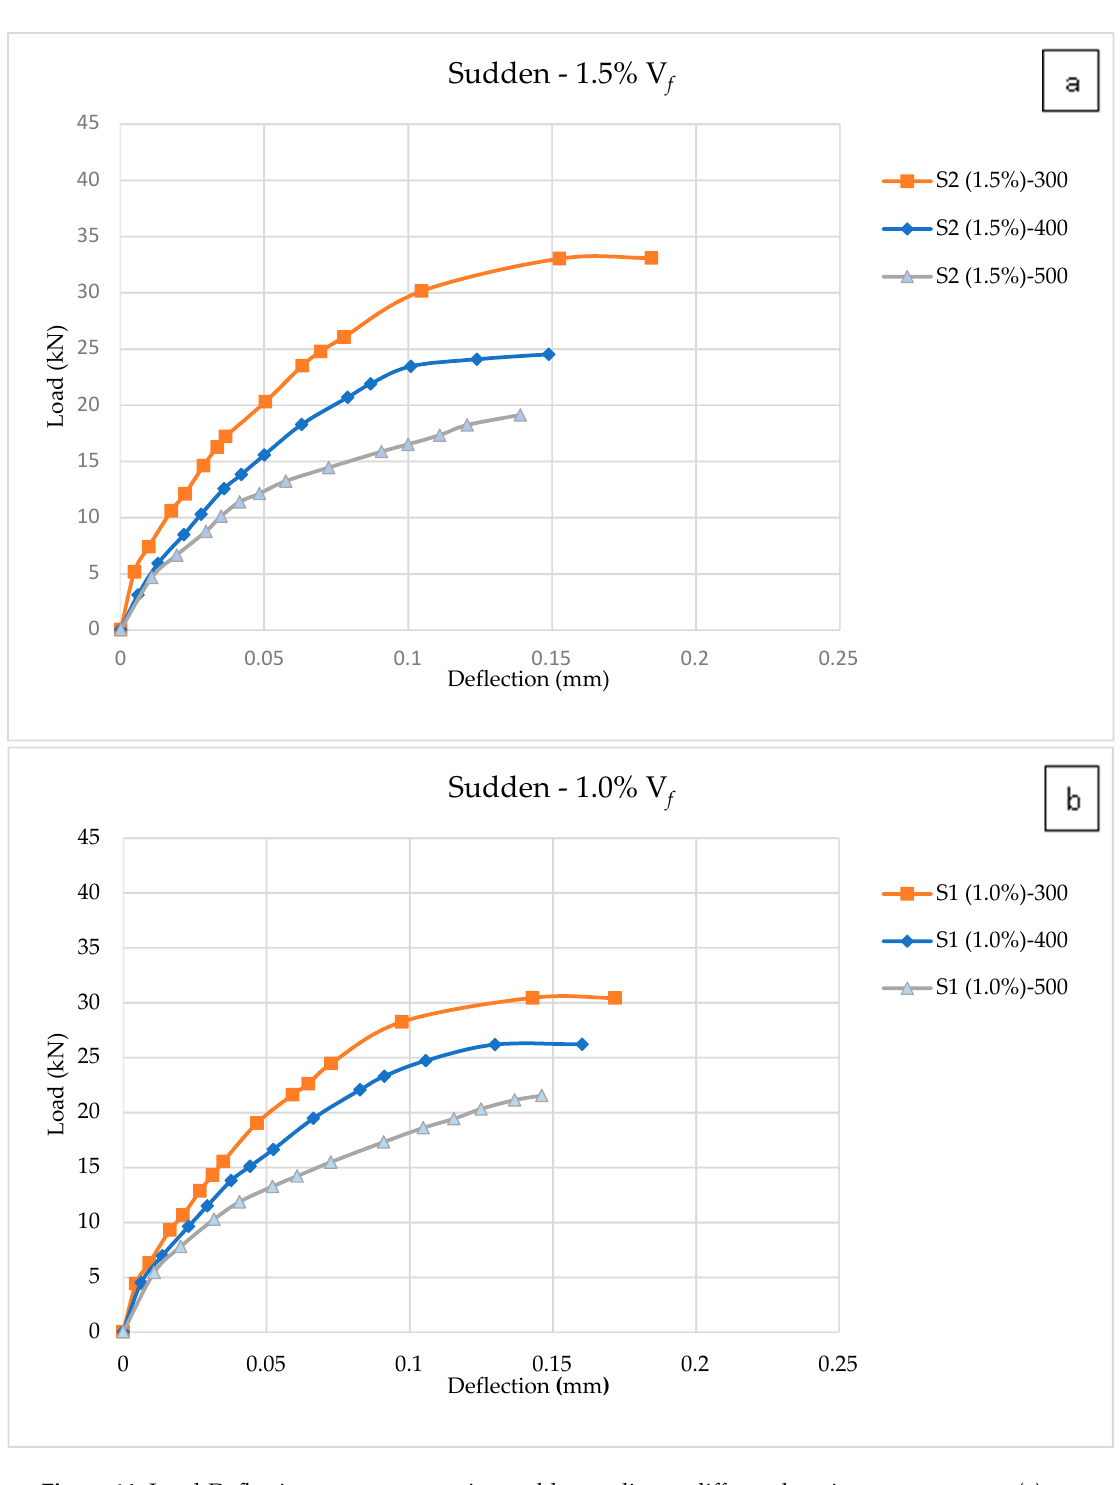
Figure 14. Load-Deflection curves concerning sudden cooling at different burning temperatures: ( a ) For 1.5% V f ; and ( b ) For 1.0% V f .